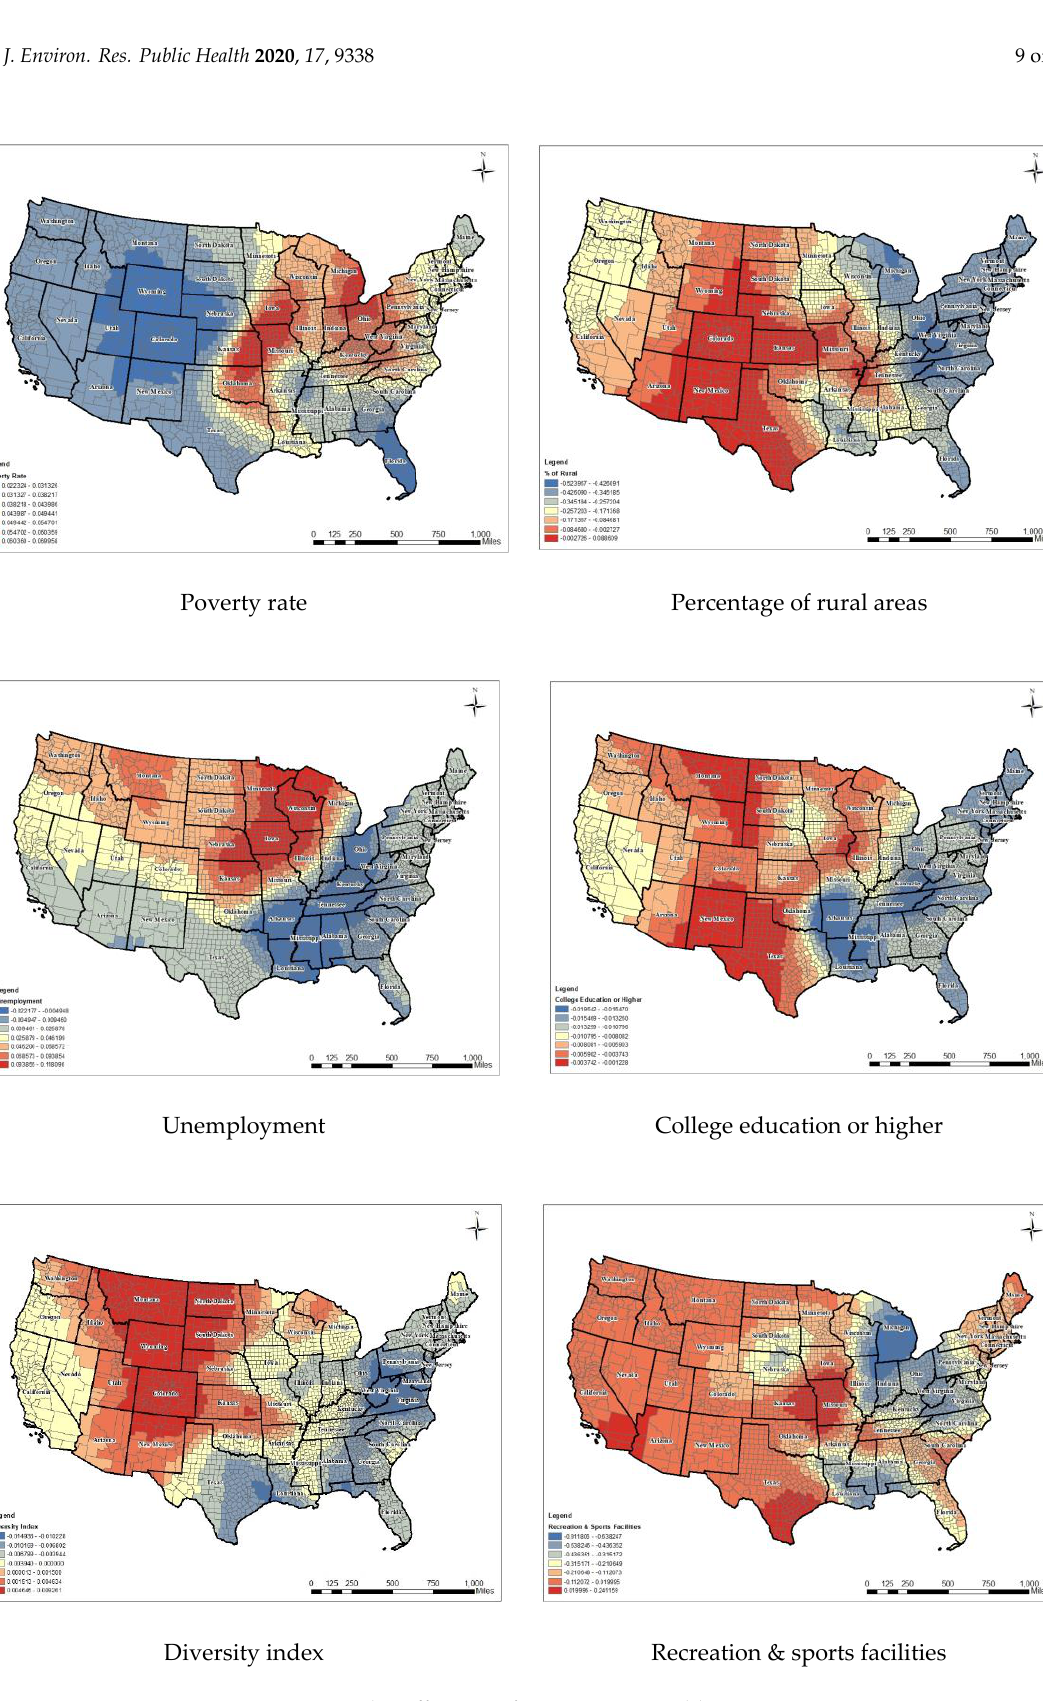
Figure 5. Local coe ffi cients of competing variables in Figure 5. Local coefficients of competing variables in GWR.